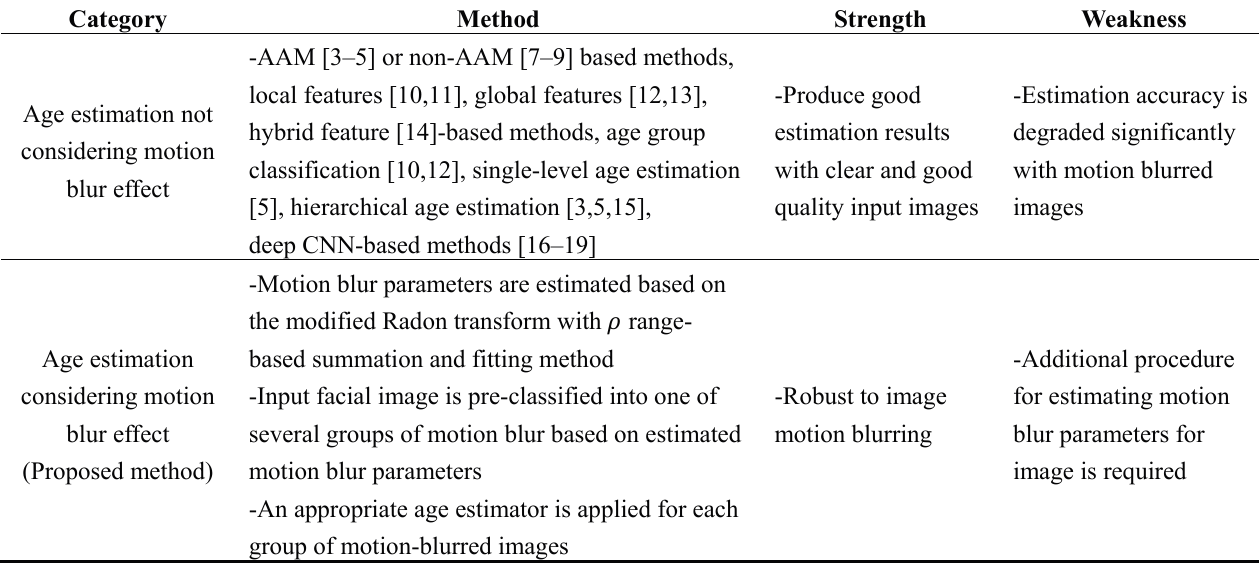
Table 1. Summary of previous and proposed studies on age